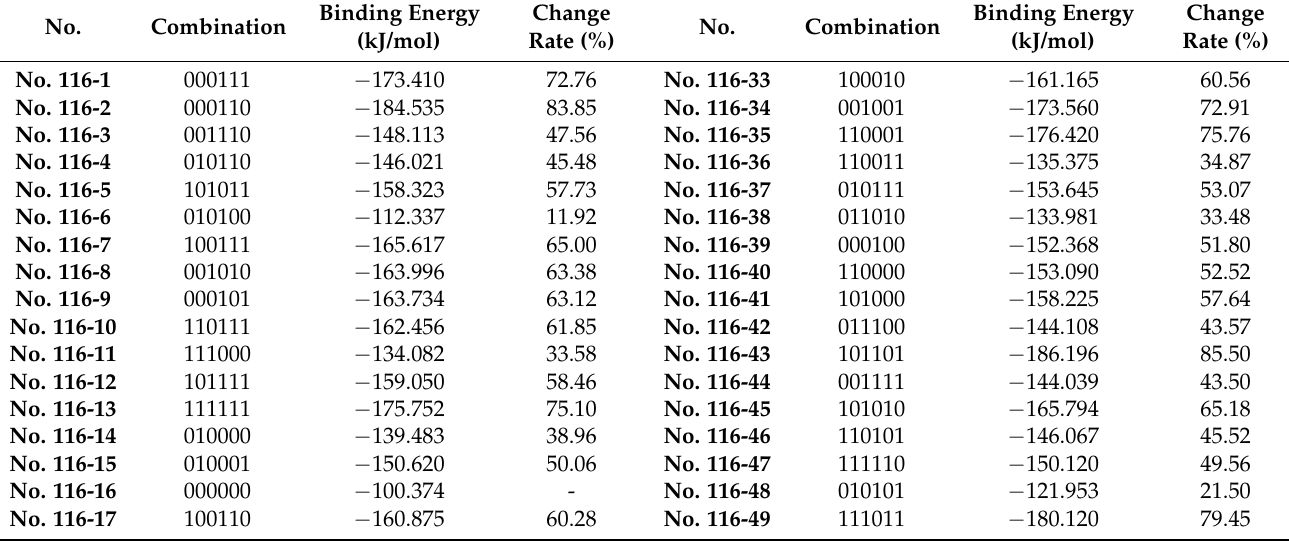
Table 5. A plan for combining plastic additives based on six components, two levels, and a full factorial design, as well as a description of its biodegradation